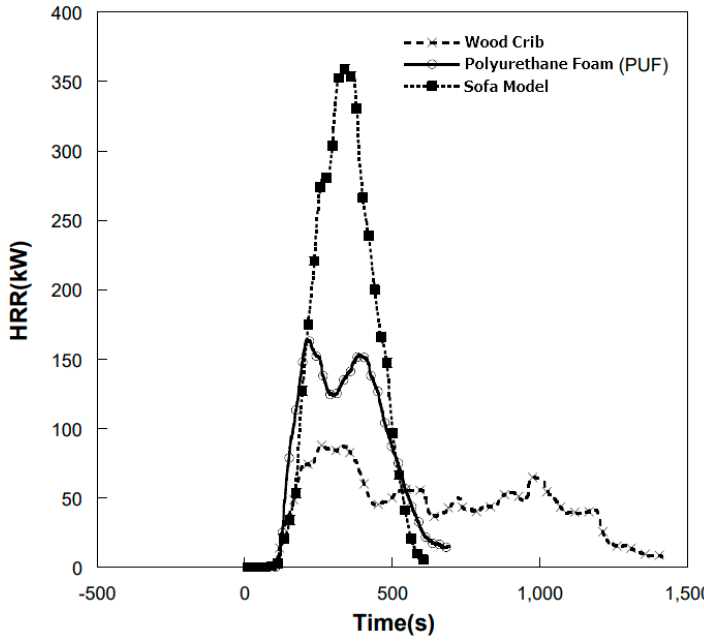
Figure 4. Heat Release Rate Per Unit Area (HRRPUA) for ( a ) polyurethane foam (PUF) and ( b ) Wood Crib.